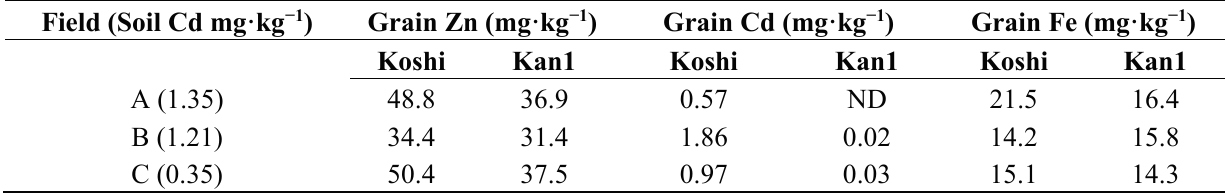
Table 4. Concentrations of Zn, Cd and Fe of grains of cultivar Koshihikari (Koshi) and its OsNRAMP5-depleted mutant Koshihikari-Kan1 (Kan1) grown on three Cd-contaminated soils whose irrigation was treated with prolonged drainage after the early-period